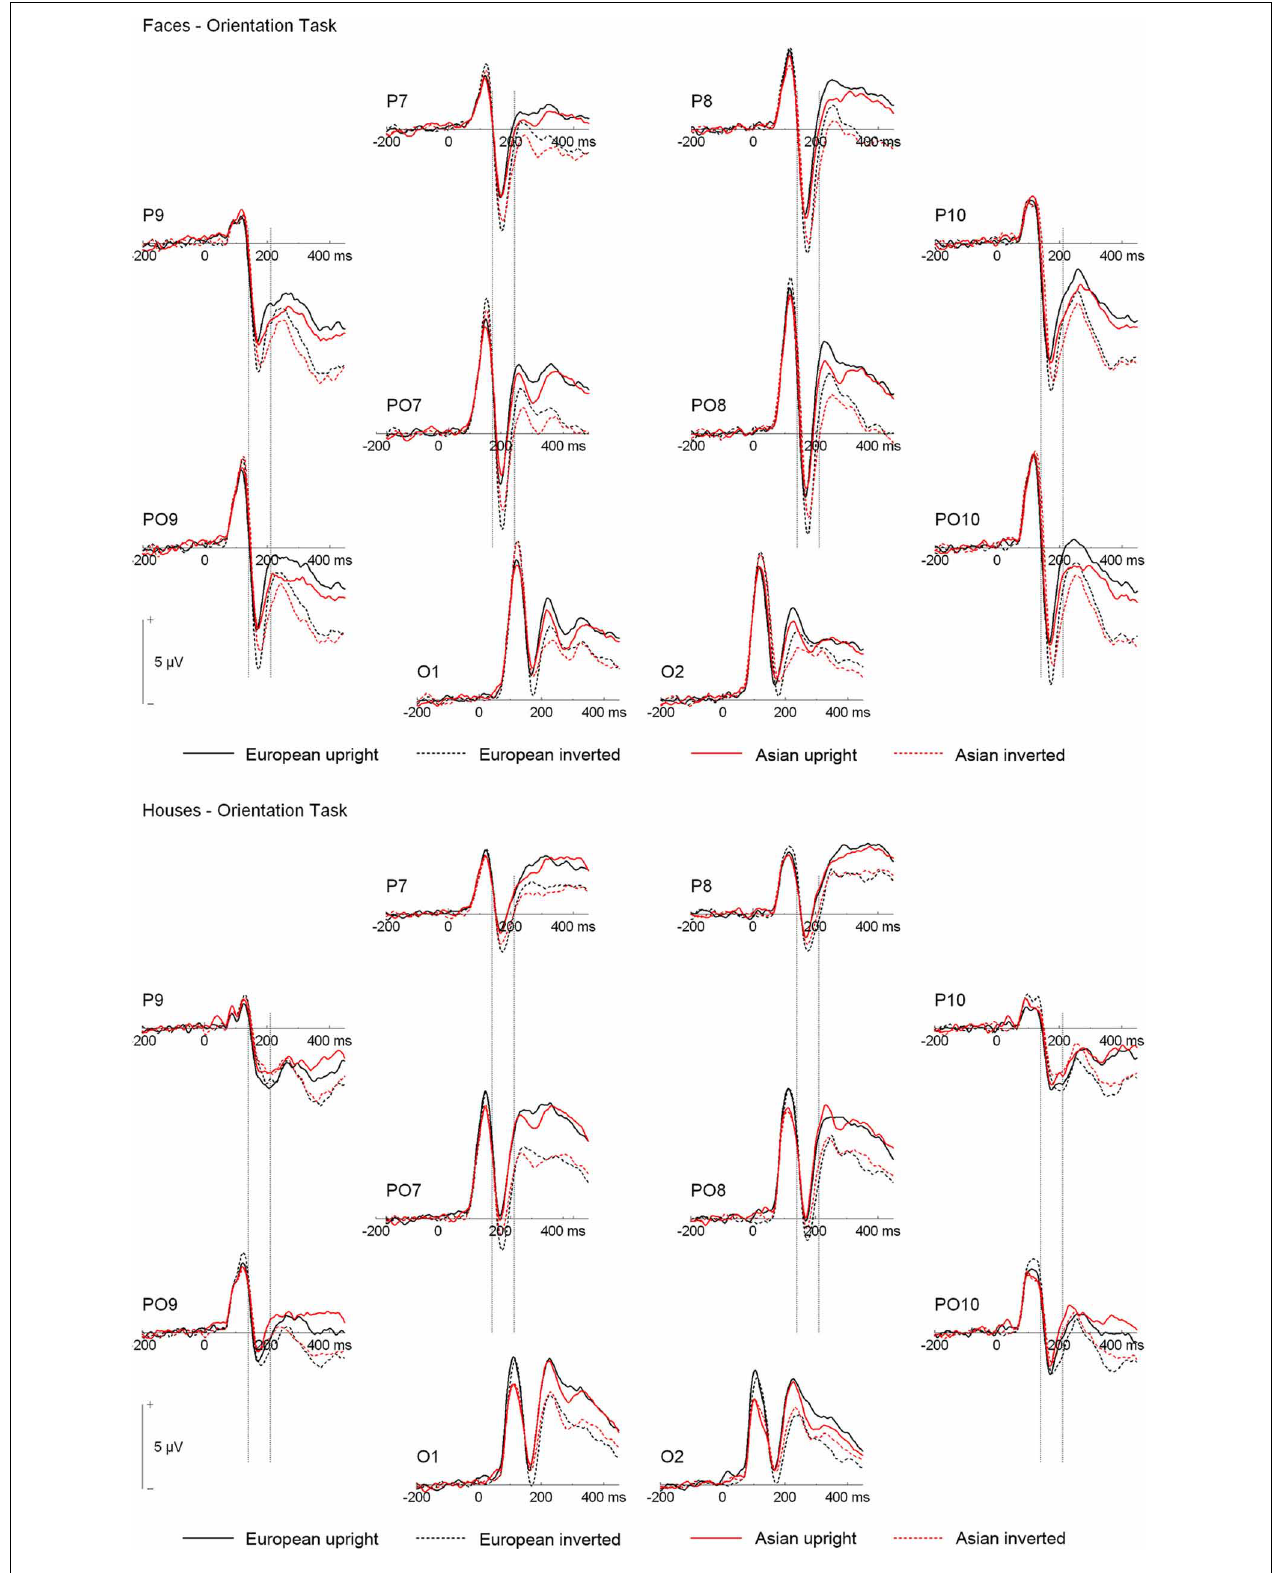
FIGURE 3 | Grand mean ERPs from the orientation task. Vertical lines indicate the N170 time window.